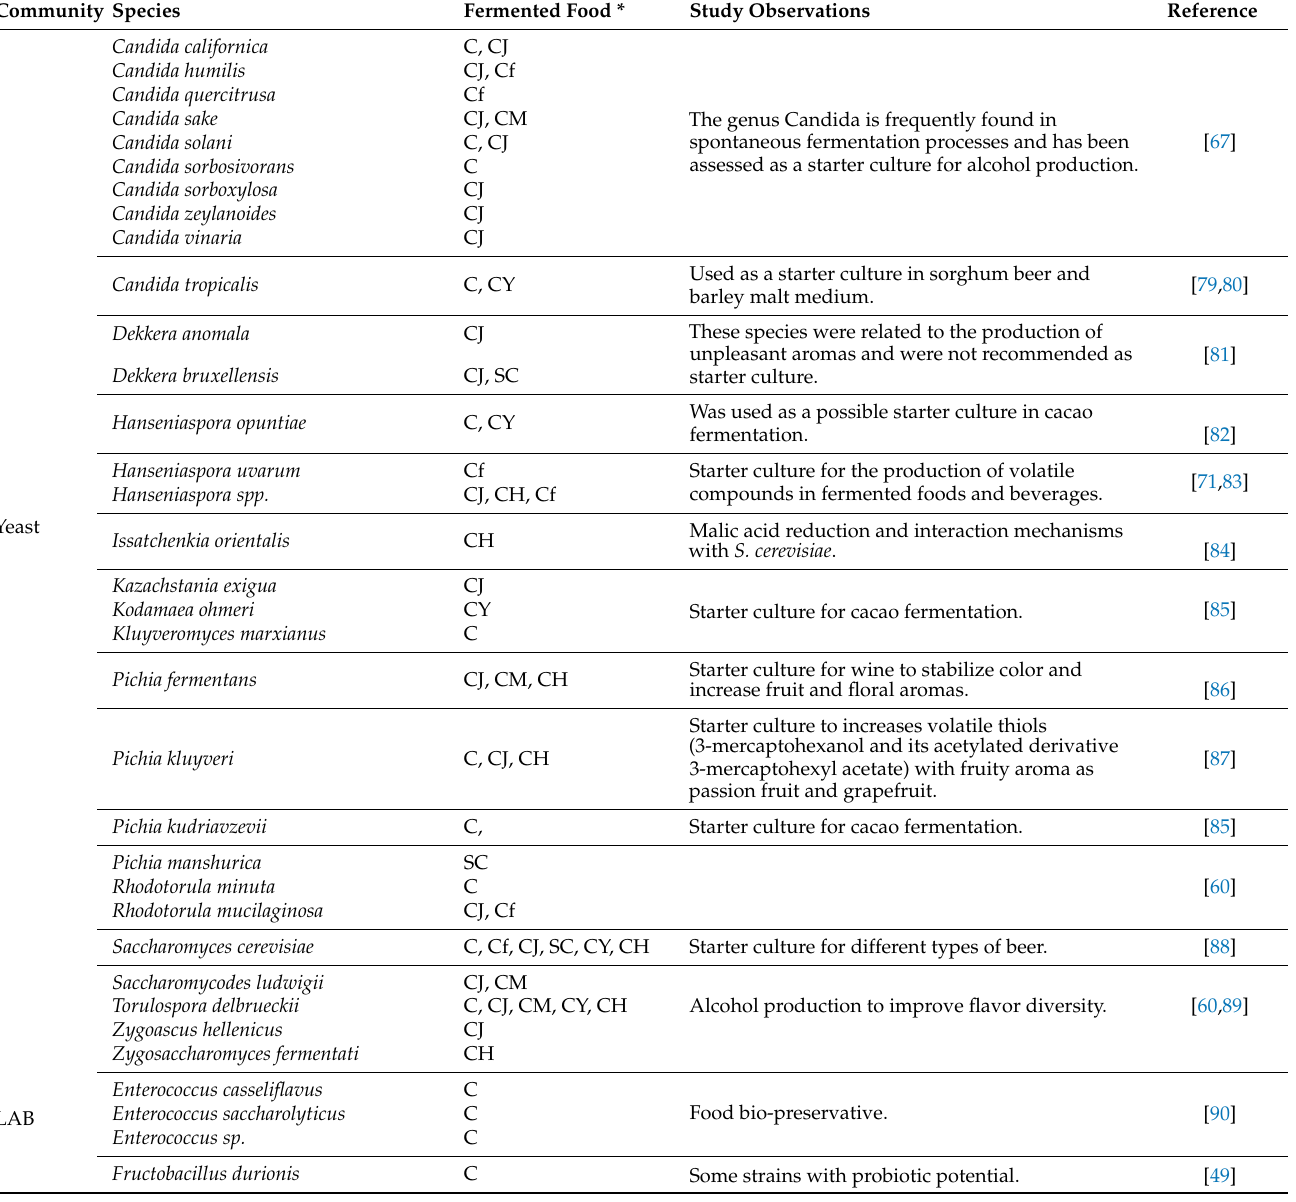
Table 2. Microbial species reported in fermented